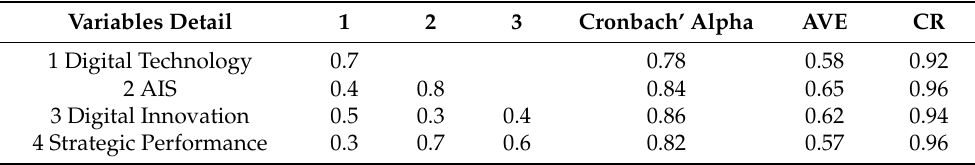
Table 3. Discriminant, Convergent, and Reliability Results.